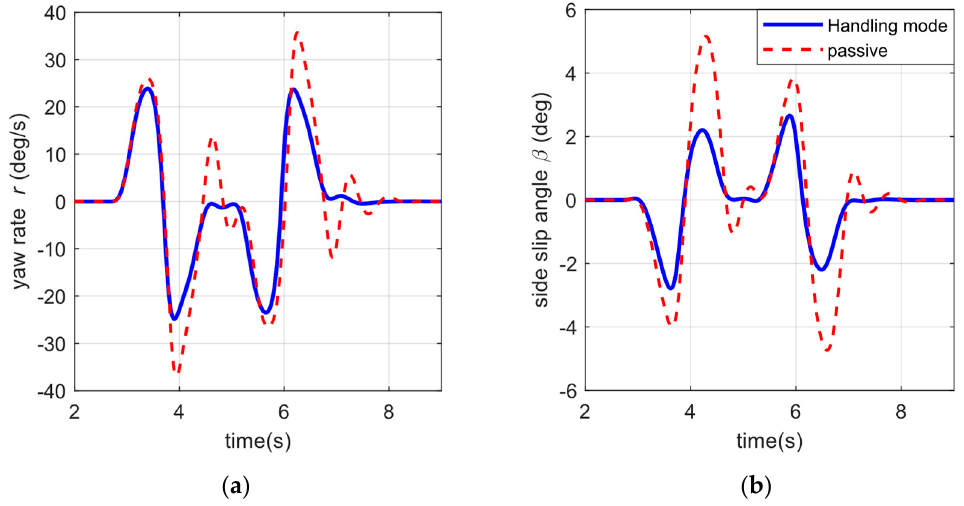
Figure 15. Results for ISO 3888-1 at 80 km/h: ( a ) Yaw rate response; ( b ) Side slip angle response.